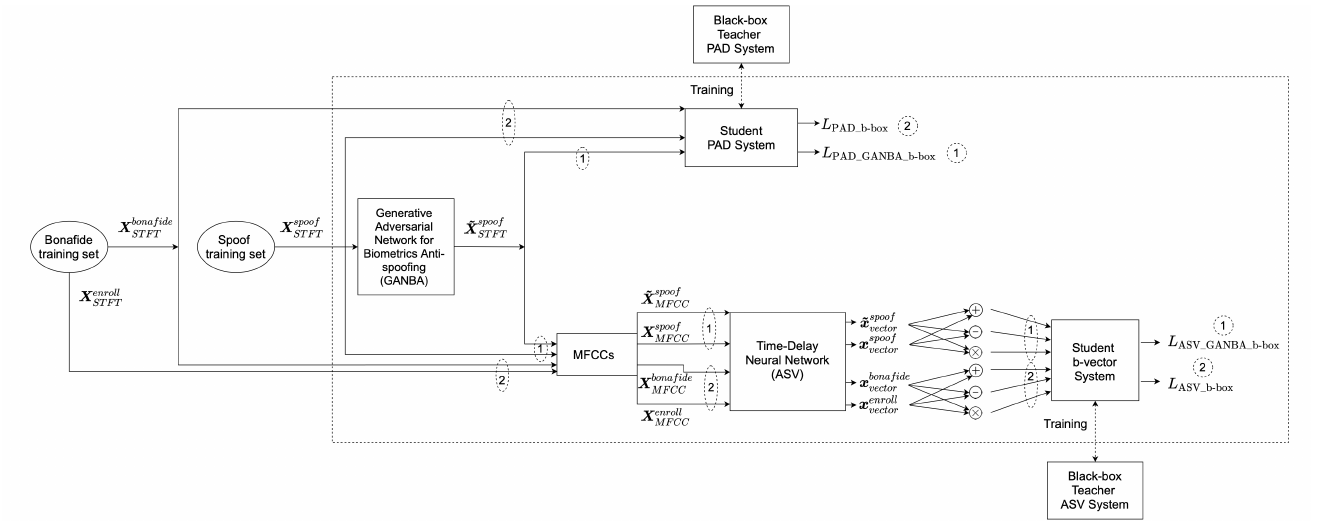
Figure 3. Generative adversarial network for biometric anti-spoofing (GANBA) framework for black-box scenarios. Step 1: generator-only training (ASV and PAD parameters frozen, with encircled outputs corresponding to Equations (11) and (12), respectively). Step 2: discriminator (ASV + PAD) training (encircled outputs corresponding to classical cross-entropy loss